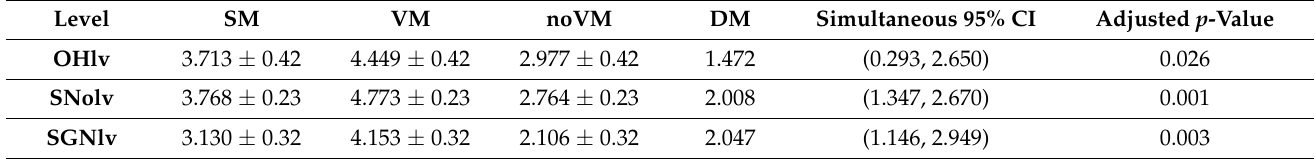
Individual confidence level = 95.00%.